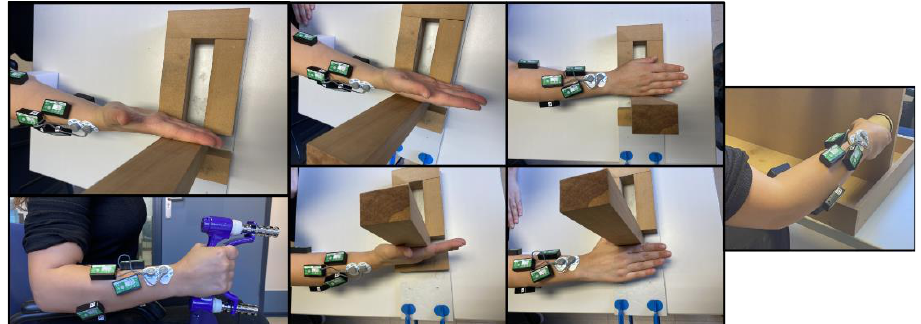
Figure 2. Seven MVC records for the normalization of the muscle activity signal. From left to right: flexion and extension of the fingers, flexion and extension of the wrist, ulnar and radial deviation of the wrist, and pronation of the forearm.